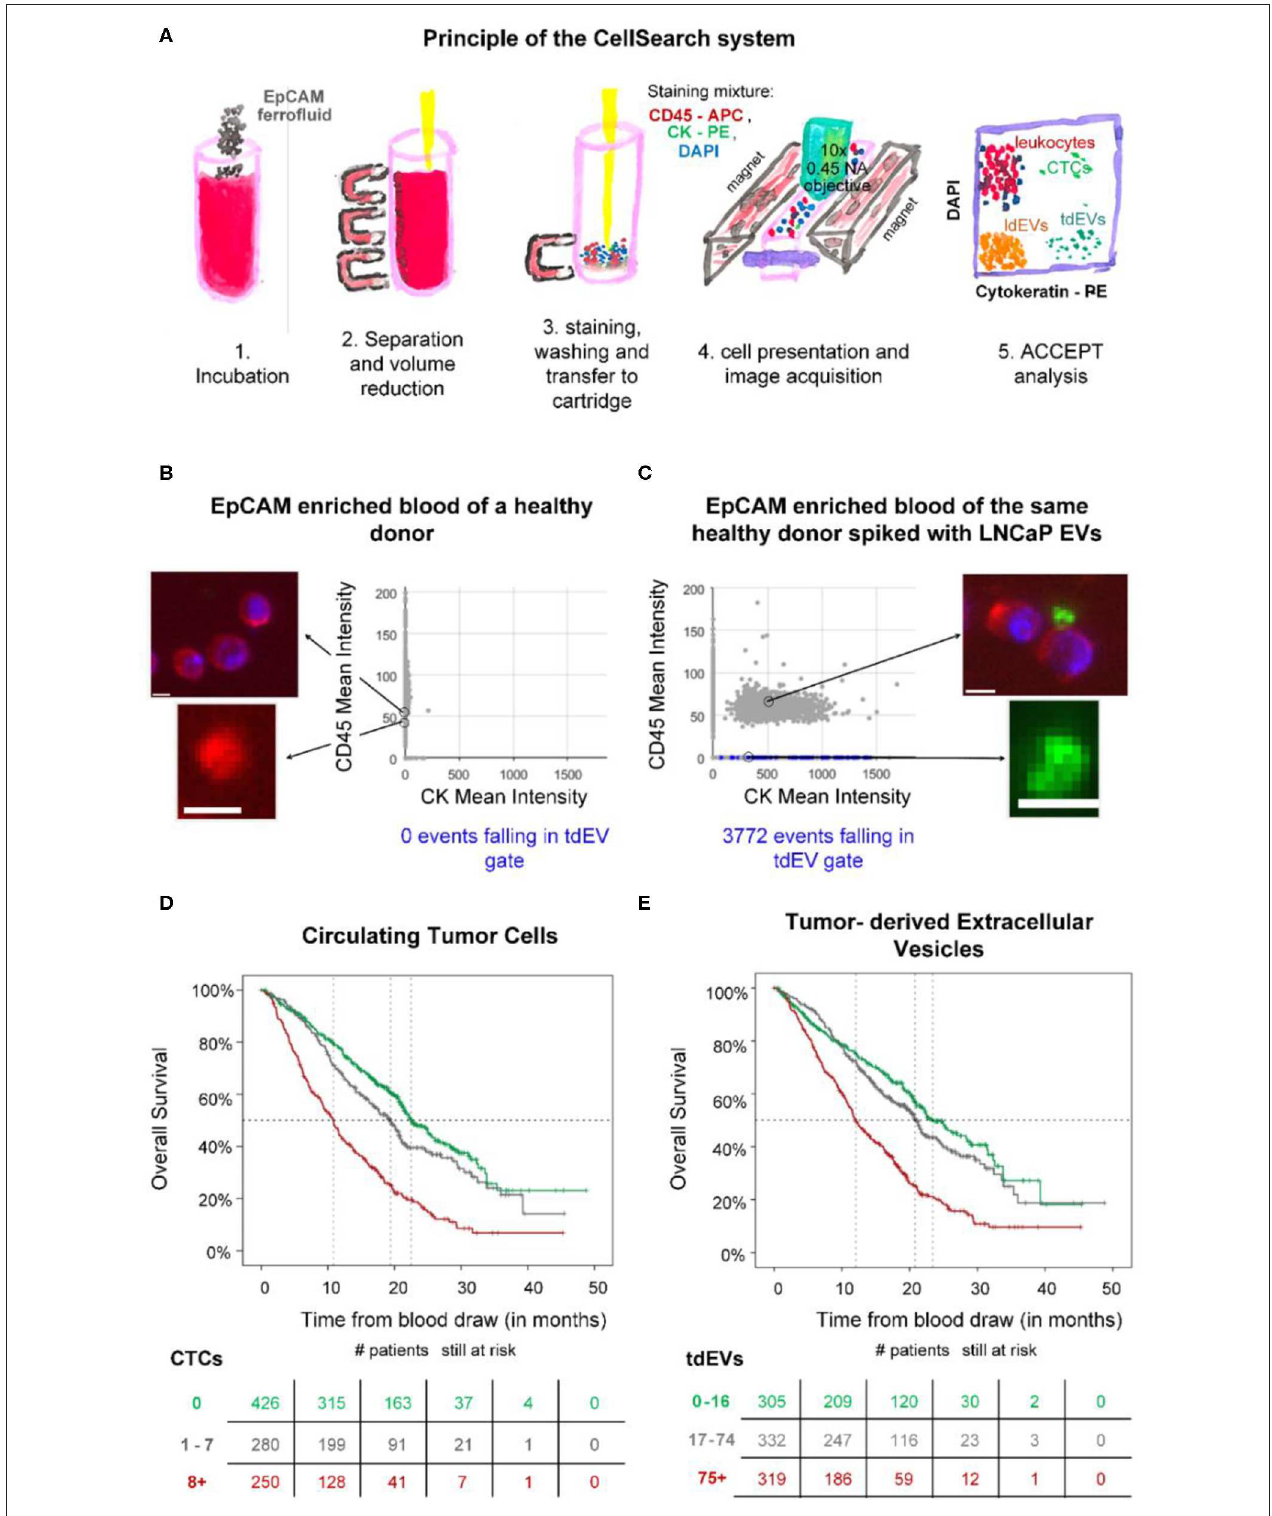
FIGURE 12 | Epithelial cell adhesion molecule (EpCAM) immunomagnetic enrichment and fluorescence microscopic (FM) detection of extracellular vesicle (EV) samples. (A) Principle of the CellSearch system. ACCEPT analysis of two CellSearch cartridges corresponding to EpCAM-enriched blood sample of a healthy